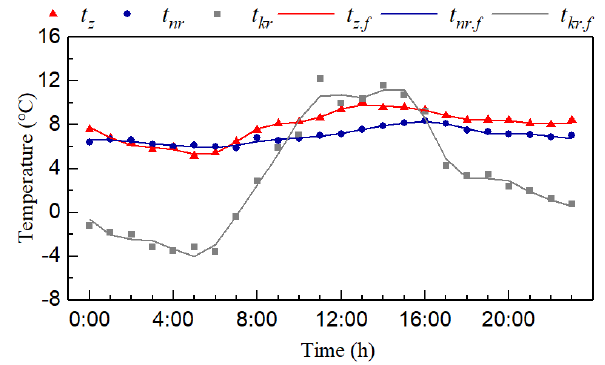
Figure 8. Fitting curves of indoor and outdoor temperature.